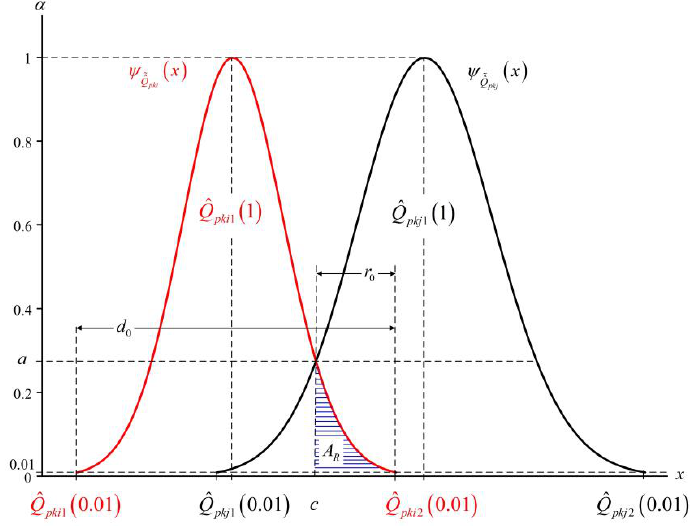
Q and ˆ Q in the decision rule. Figure 2. The relationship of (cid:101) ˆ Q pki and (cid:101) ˆ Q pkj in the decision pki pkj